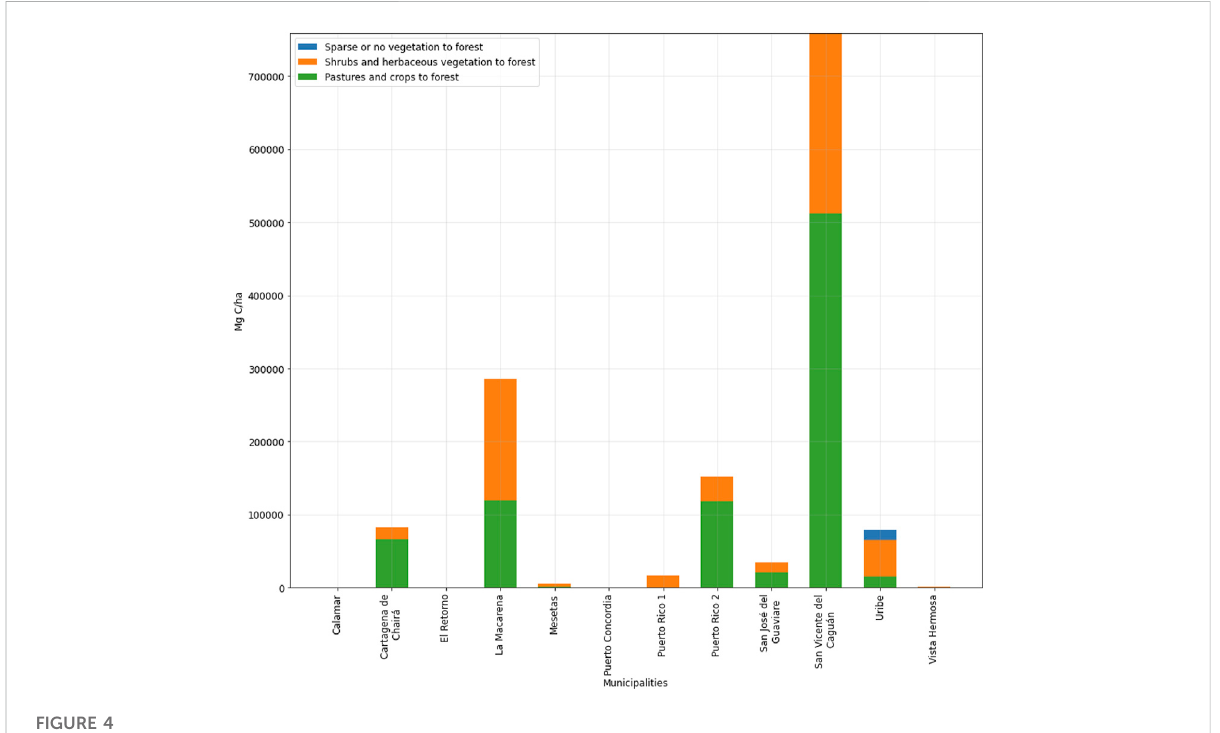
FIGURE 4 Carbon storage due to forest regeneration and/or degradation (Mg C) by municipality and land use and land cover transition in the study area during 2009 – 2012.